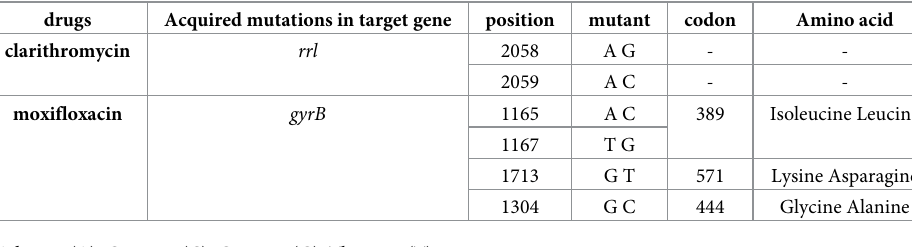
Table 7. Mutation patterns against clarithromycin and moxifloxacin resistance strains.